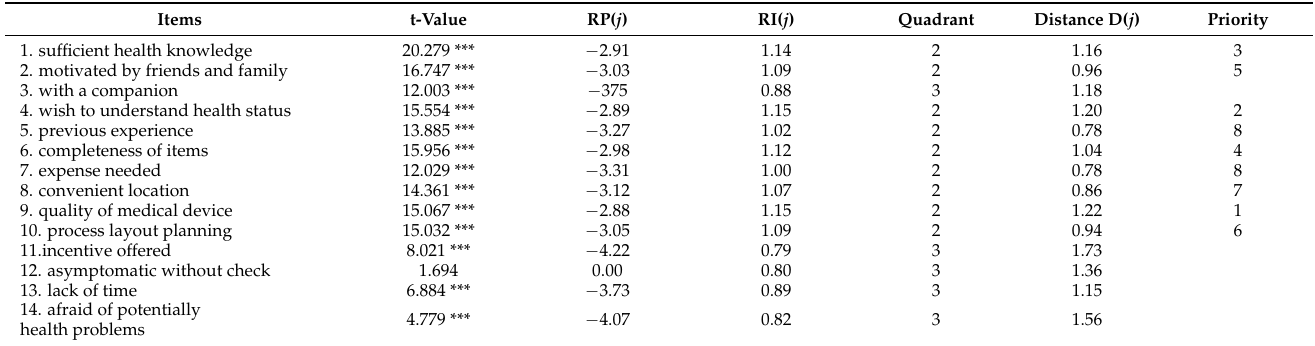
Table 3. Results of the importance–performance gap analysis.